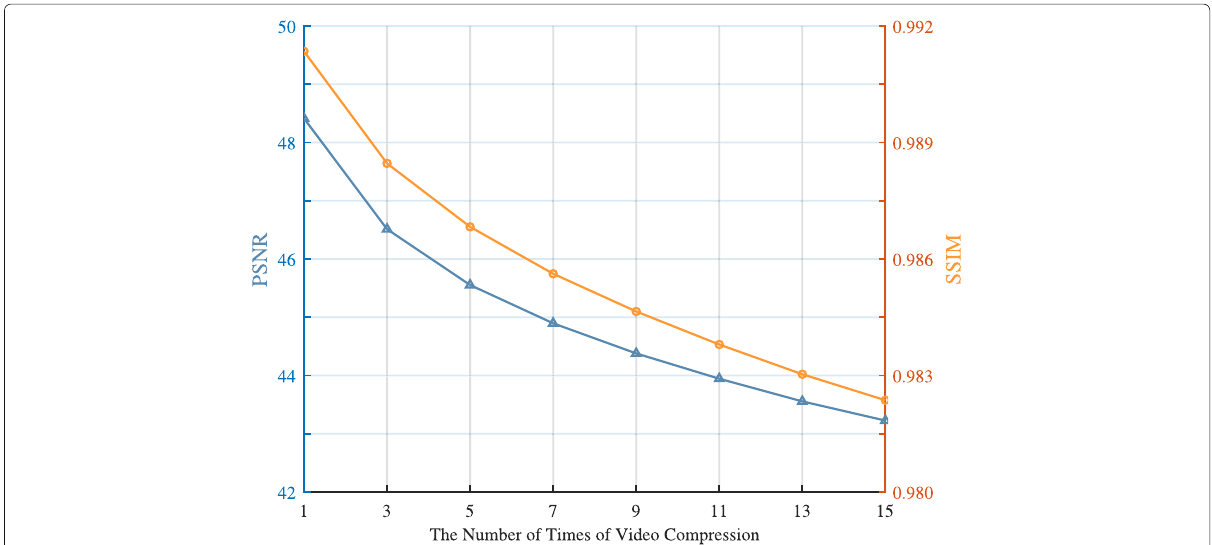
Fig. 8 The PSNR and SSIM between the raw video and videos recompressed by a specific channel. We calculate the values of PSNR and SSIM between the raw video and the recompressed video every